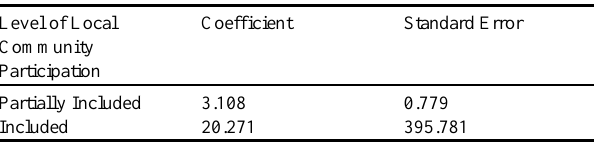
Table 4. Regression coefficients for the model with participation as the only independent